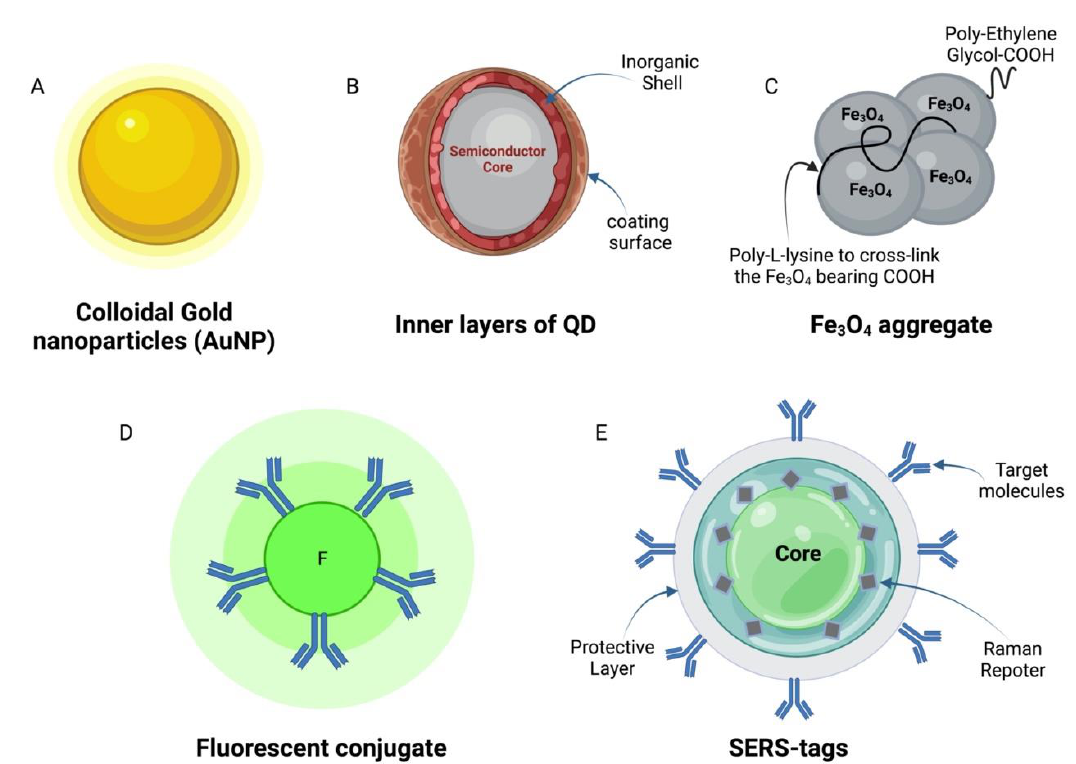
Figure 5. Types of LFIA reporters: ( A ) Colloidal gold nanoparticles (AuNP), ( B ) the inner layers of the QDs, ( C ) an example of the magnetic particles (Fe3O4) aggregate, ( D ) fluorescent conjugate, and ( E ) SERS-tag.